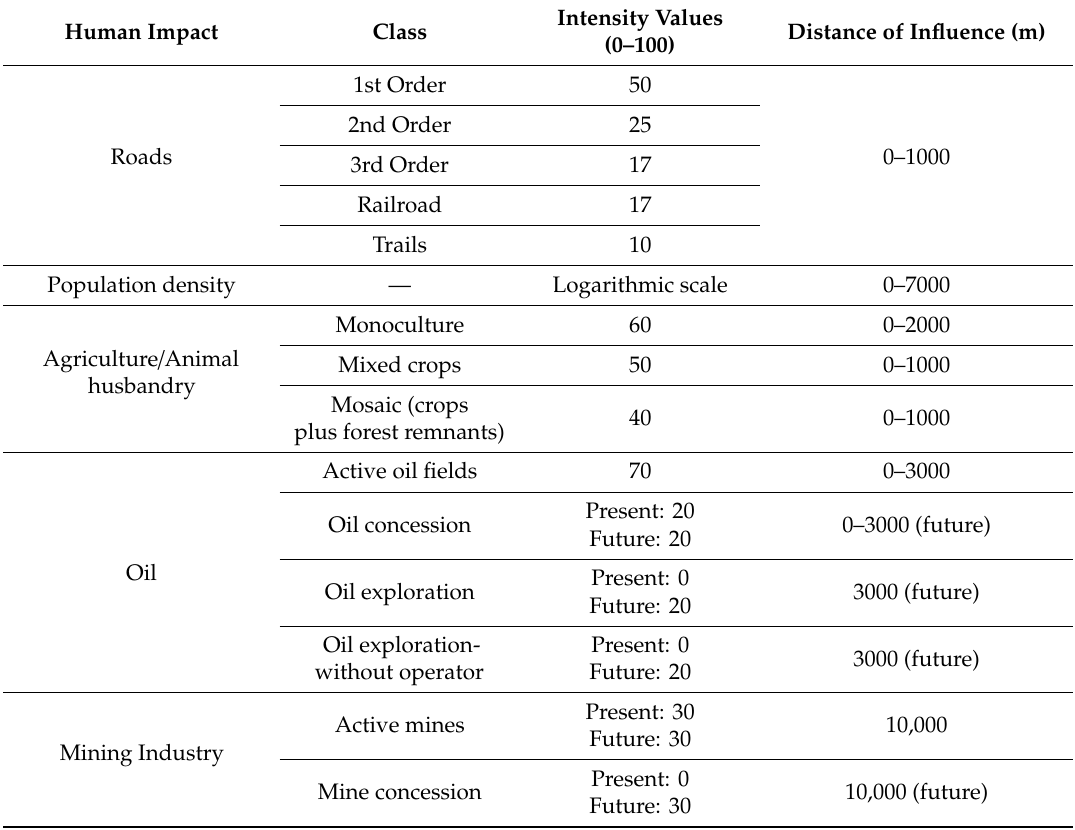
Table 4. Intensity values and distance of influence of human